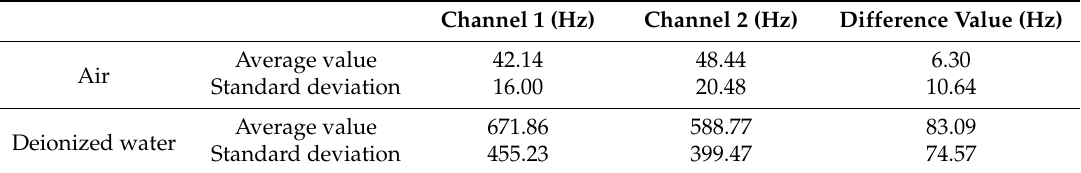
Table 2. Frequency shift of dual-channel QCMs in air and deionized